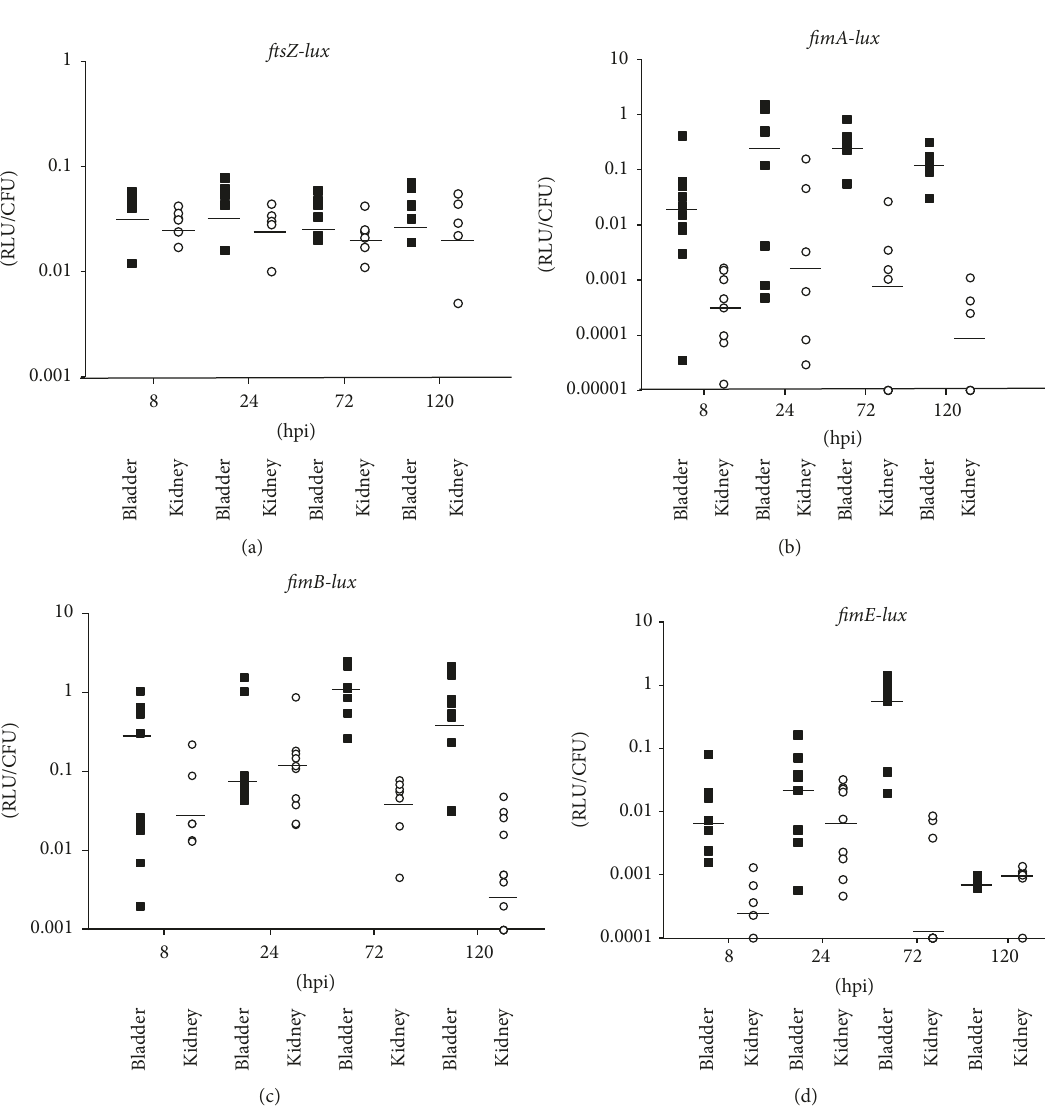
Figure 3: Expression of ftsZ (a), fimA (b), fimB (c), and fimE (d) in murine tissues after infection with E. coli strain NU149 as determined with fim::luxABCDE transcriptional fusions after 8, 24, 72, and 120 hours after inoculation (hpi). Murine tissues included bladder (black square) or kidney (white circle). RLU/CFU were measured with a luminometer, background fluorescence subtracted, and then divided by viable counts; median values are indicated. Five to twelve animals per time point were examined where each symbol represents one mouse. The black horizontal bars represent the median values for each time point and